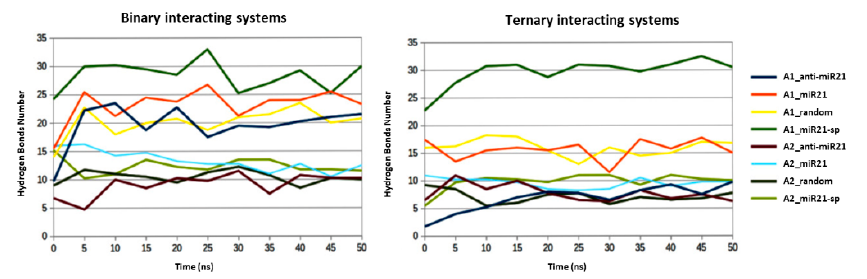
Figure 9. Hydrogen bond plots for A1/A2@GNRs and corresponding oligonucleotides.